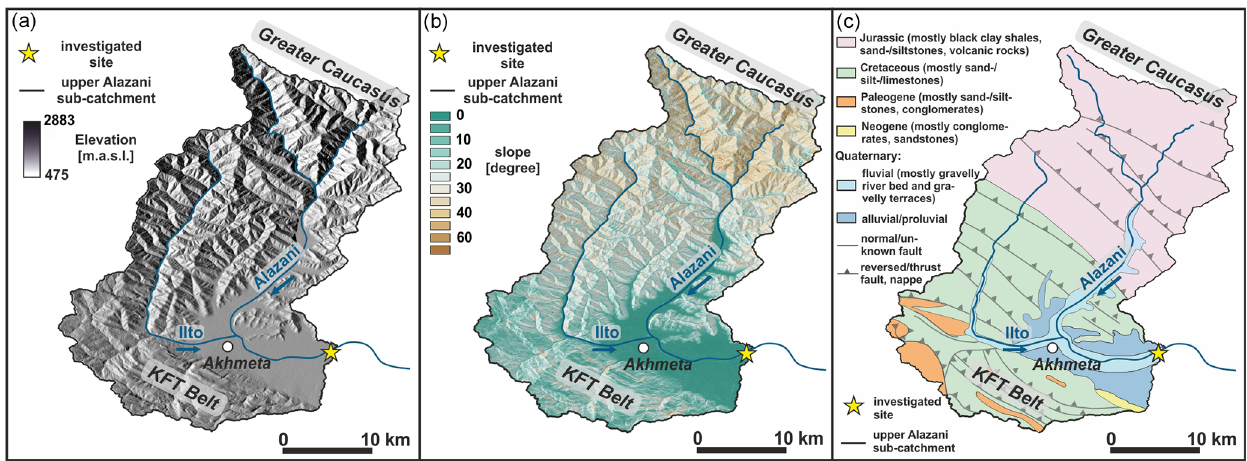
Figure 2. (a) Digital elevation model of the upper Alazani subcatchment (SRTM30-DEM). (b) Slope map of the upper Alazani subcatchment. (c) Geological map of the upper Alazani subcatchment (simplified after Gamkrelidze, 2003). KFT belt: Kura fold-and-thrust